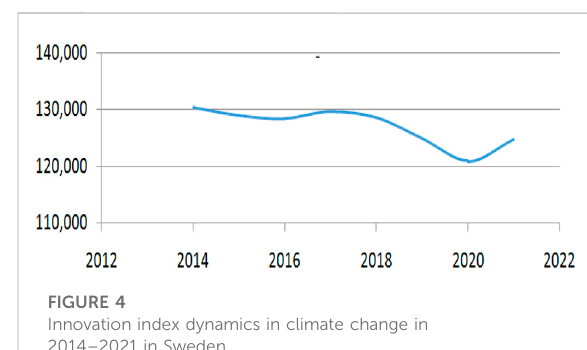
FIGURE 6 ModellingofInnovationindexdynamicsinclimatechangefor two investment programs in 2014 – 2021 in Denmark.